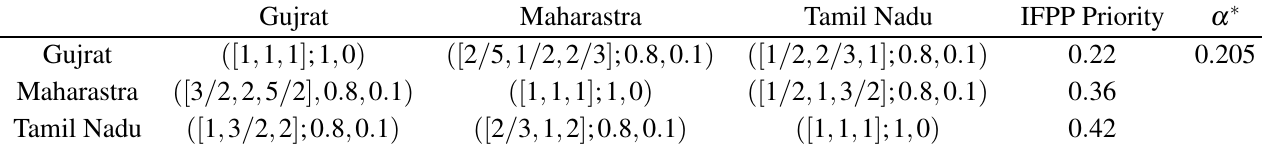
Table 8: Generalized intuitionistic fuzzy pair-wise comparison matrix with respect to PR Gujrat